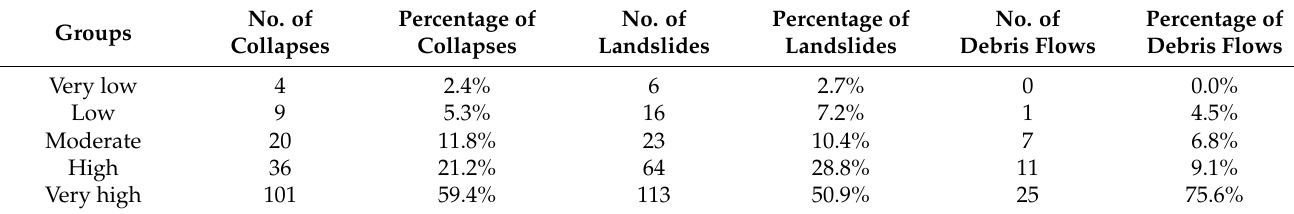
Table 10. The sample statistical results of the multiple susceptibility